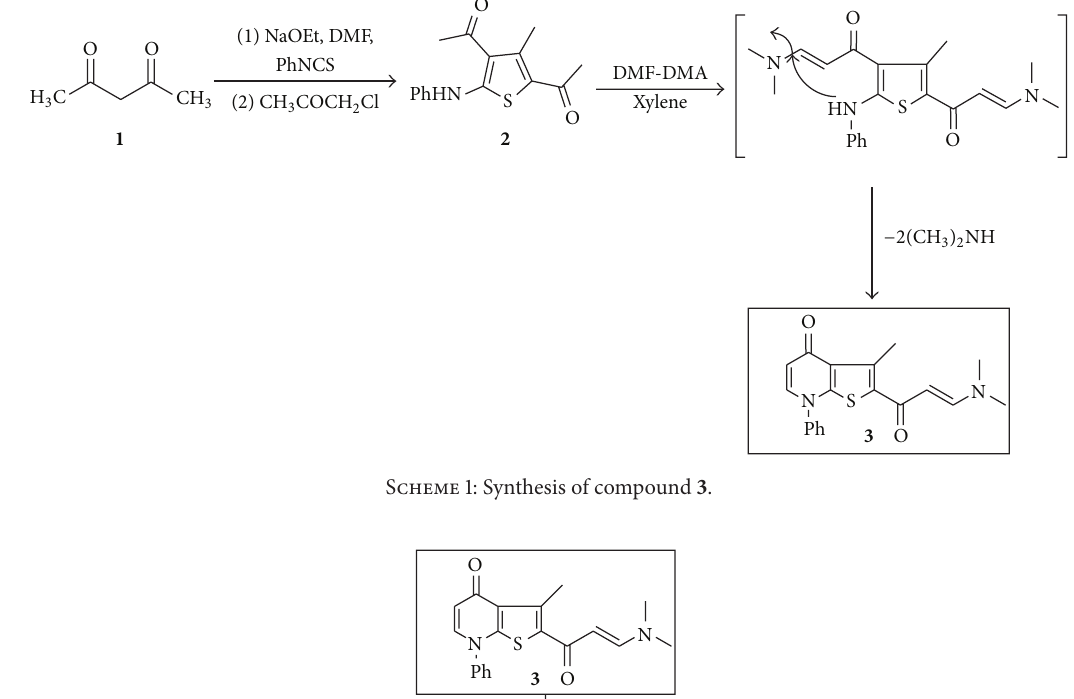
Scheme 1: Synthesis of compound 3 .